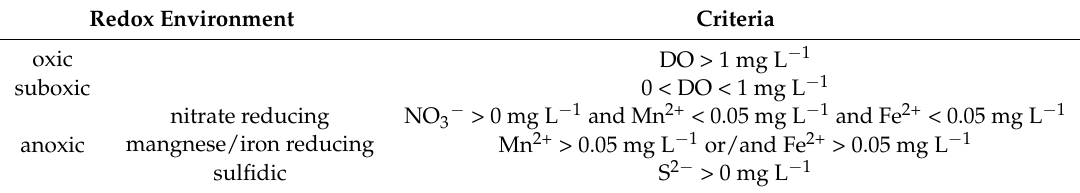
Table 1. Classification scheme used for redox